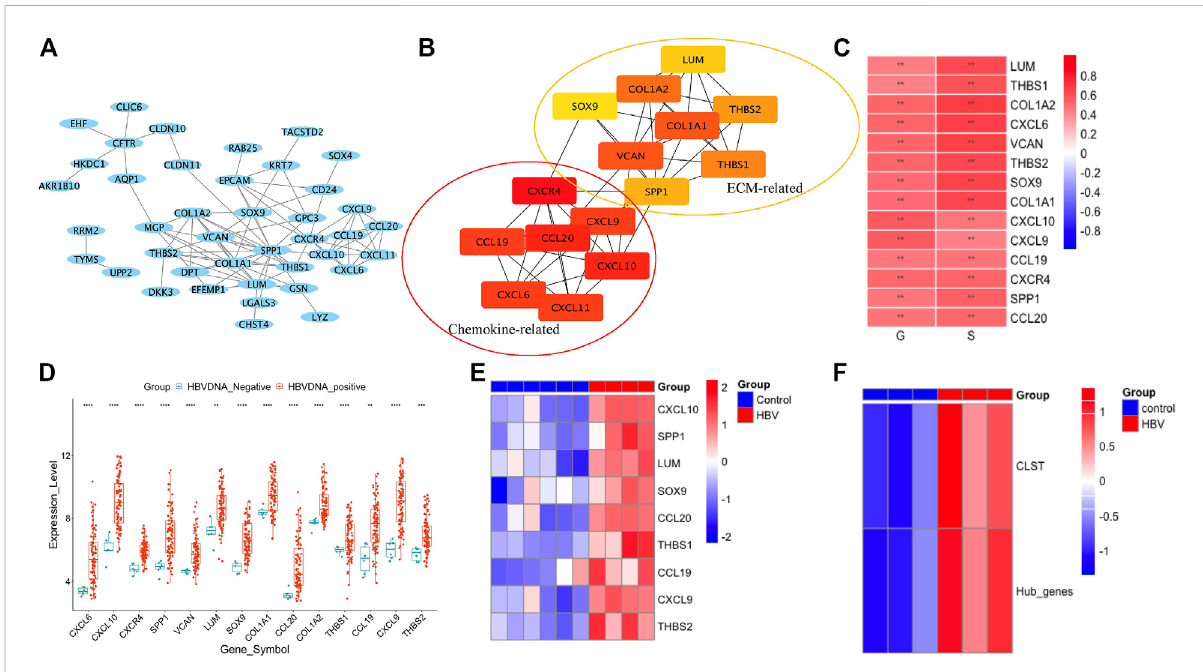
FIGURE 1 CLST identi fi cation. (A) PPI network of overlapping DEGs by STRING (GSE84044). (B) Seven chemokine-related genes and eight ECM-related genesintwogroupswerefurtheridenti fi edusingCytoscapeofMCODEplug-in. (C) Correlationsamongexpressionvaluesof14hubgenes,Gscores, and S scores. (D) Dot plots of 14 GS-associated hub genes in liver samples of CHB group and control group. (E) Heatmap of nine hub genes in HBV- infected mice and control mice. (F) Heatmap showing ES of gene set comprised of 14 GS-associated hub genes and CLST in HBV-PHH and control